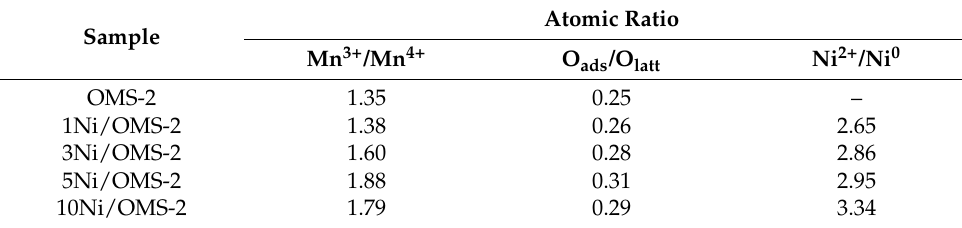
Table 2. Surface element compositions of the as-prepared